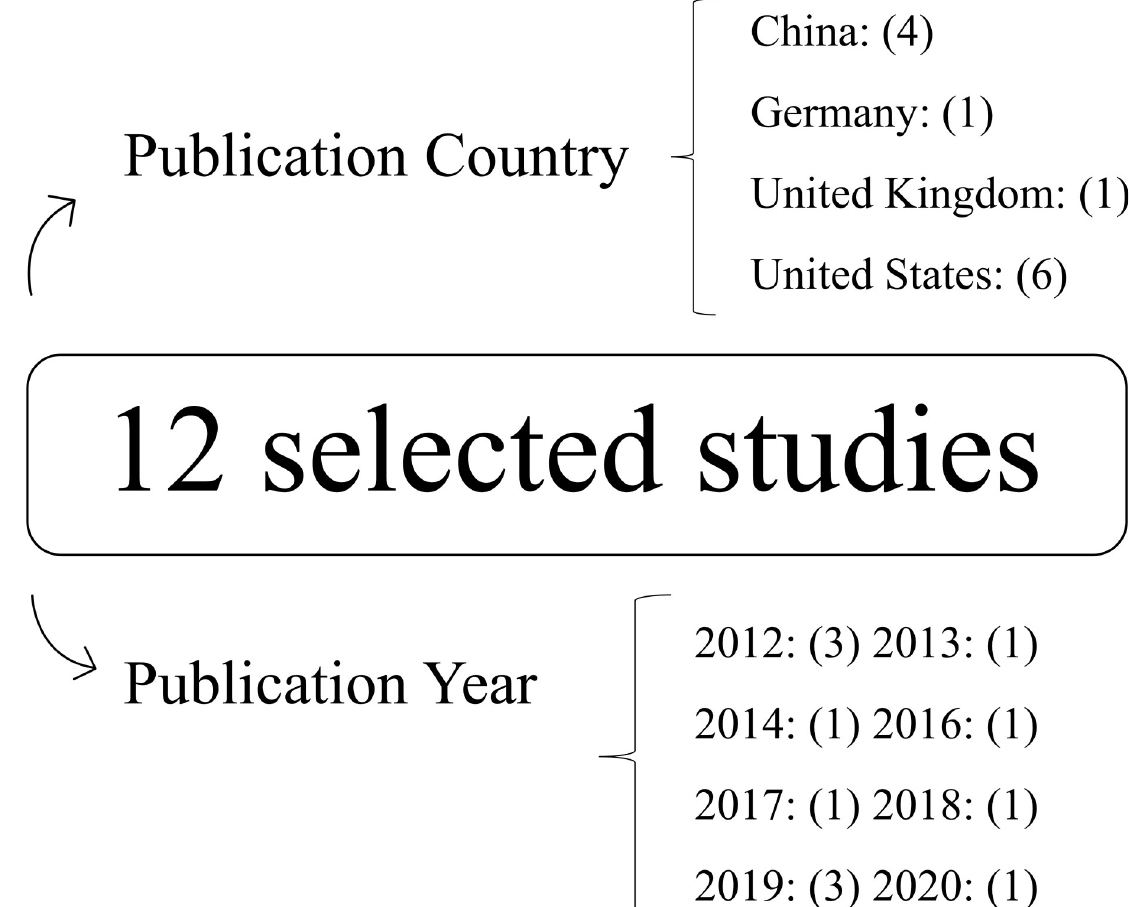
Fig 2. Correlation between publication countries and years of selected articles. Correlation between publication countries and years of selected articles.